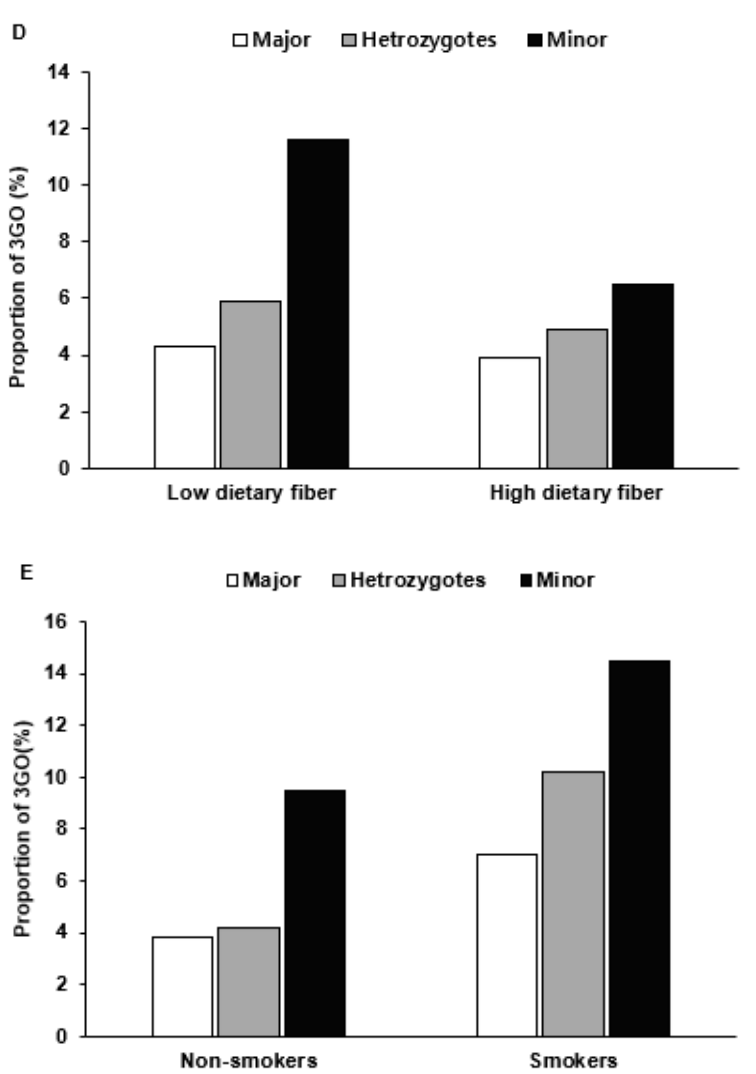
Figure 3. The proportion of participants with the major, heterozygous, and minor alleles of the haplotype in 11q23 accord- haplotype in 11q23 according to high- and low-nutrient intake and smoking status. The proportions ing to high- and low-nutrient intake and smoking status. The proportions of 3GO were provided in a low and high intake of 3GO were provided in a low and high intake of protein (( A ) Cutoff: 13% energy), fat (( B ) Cutoff: of protein (( A ) Cutoff: 13% energy), fat (( B ) Cutoff: 15% energy), carbohydrate (( C ) Cutoff: 70% energy), and dietary fiber 15% energy), carbohydrate (( C ) Cutoff: 70% energy), and dietary fiber (undigested carbohydrate; (undigested carbohydrate; ( D ) Cutoff: 5 g/1000 kcal) intake and smoking status ( E ). ( D ) Cutoff: 5 g/1000 kcal) intake and smoking status ( E